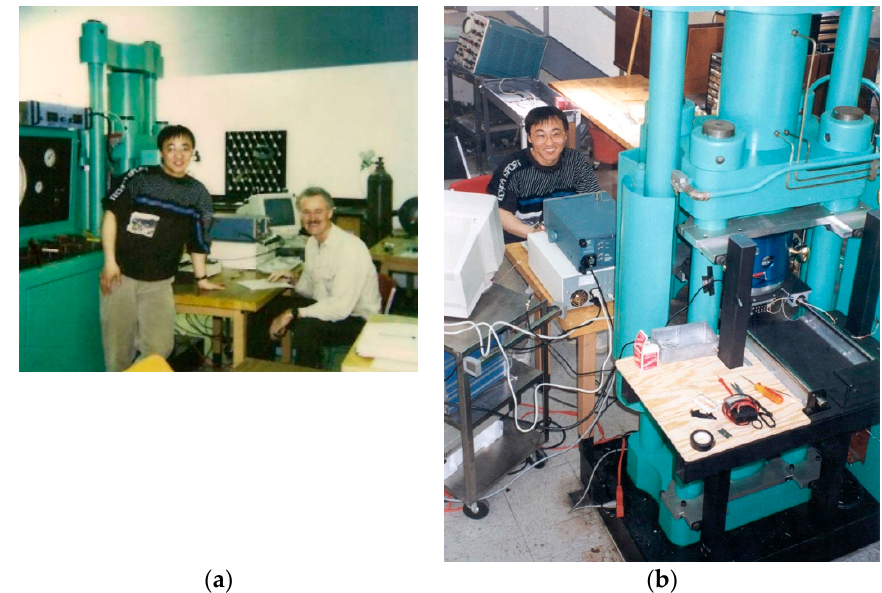
Figure 3. ( a ) May 1994. Baosheng Li and Ian Jackson in the Stony Brook High Pressure Laboratory. Ian spent 6 weeks in our laboratory working with Baosheng on interfacing the ANU ultrasonic interferometry system with the 1000-ton split-cylinder apparatus of the Kennedy–Getting type [35]. Reproduced with permission from Liebermann [1], published by Elsevier B.V., 2014. ( b ) Baosheng Li and Kennedy-Getting press with Walker-type module in High Pressure Lab in 1994. Reproduced with permission from Liebermann [1], published by Elsevier B.V., 2014.